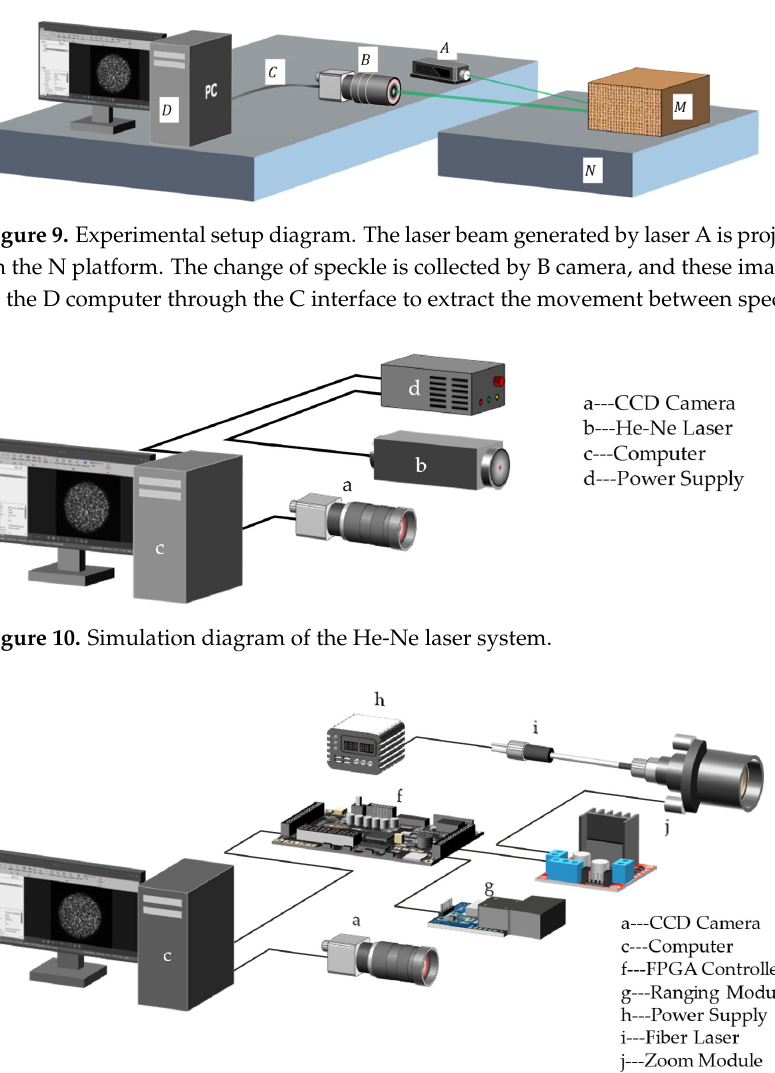
Figure 11. Simulation diagram of the fiber laser system.